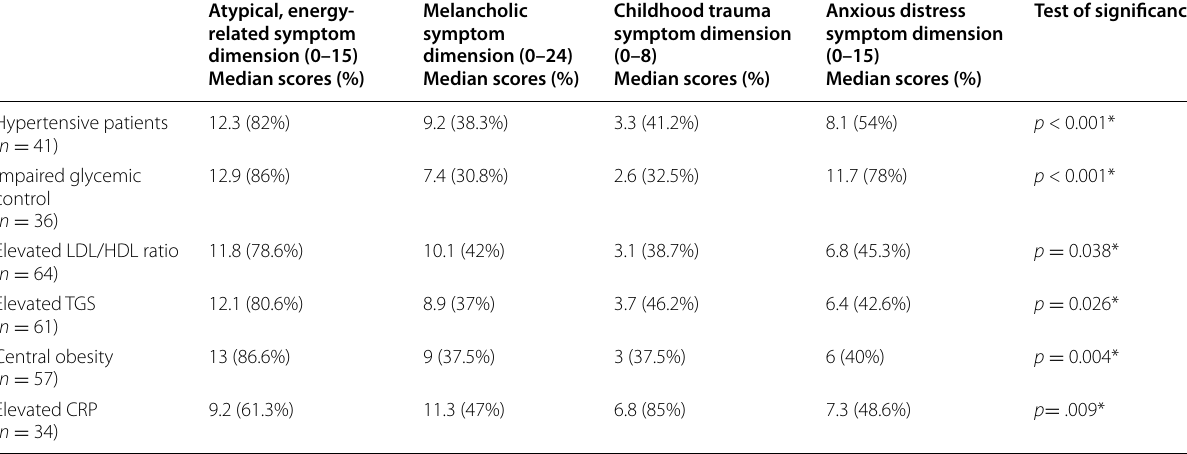
*Statistically significant if p <